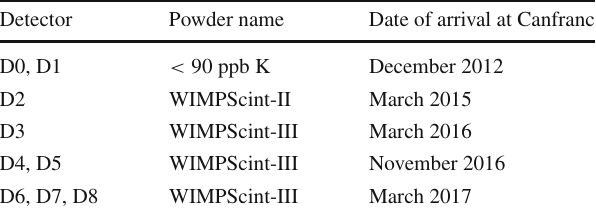
Table 1 Powder name and date of arrival at LSC for the nine detectors of ANAIS-112 produced by Alpha Spectra